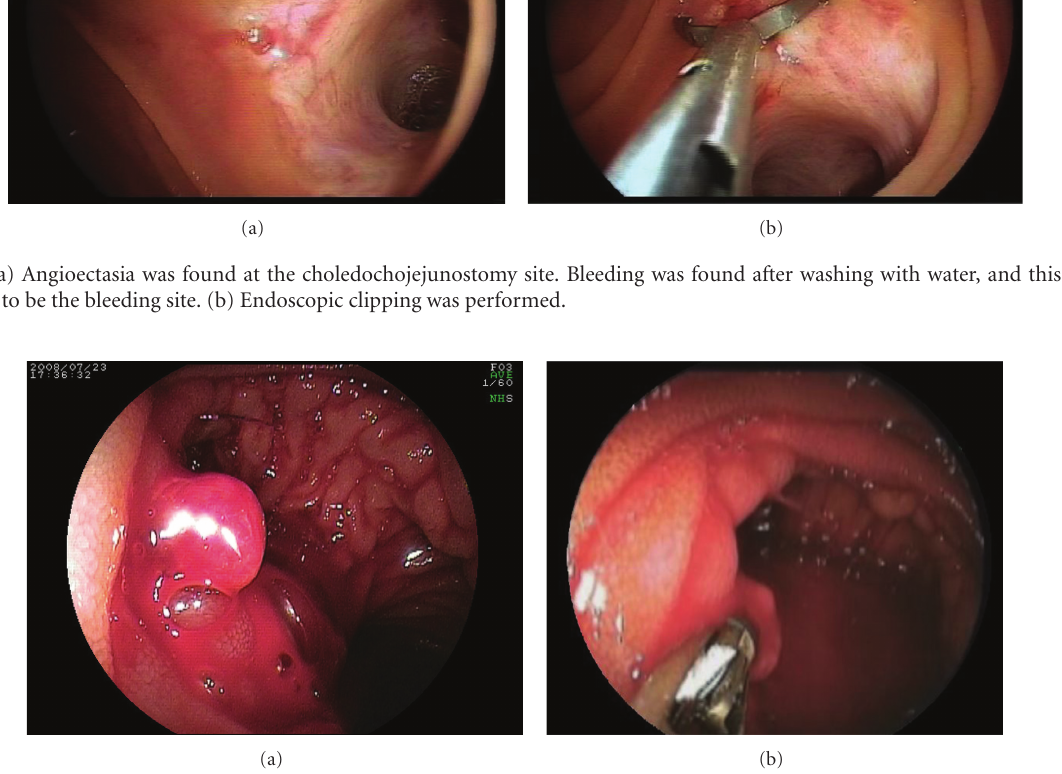
Figure 3: (a) A pulsatile, exposed vessel was found at the anastomotic site of the a ff erent loop; (b) Hemostasis was achieved using hemostatic